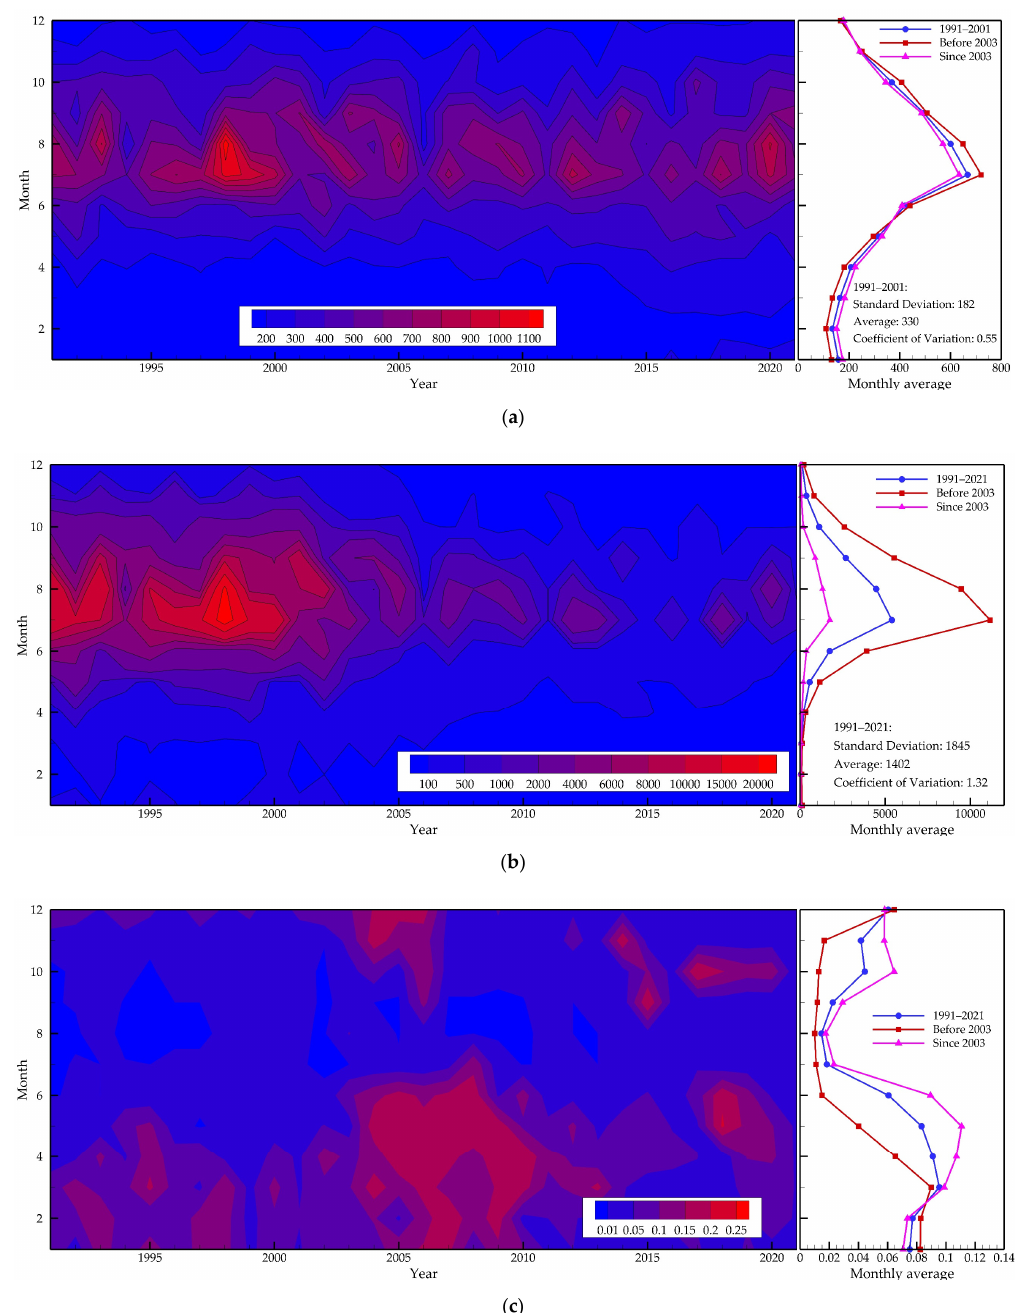
Figure 6. Contour maps of the monthly distribution and multiyear average values at Shashi station. ( a ) Runoff, unit: 10 8 m 3 ; ( b ) Sediment discharge, unit: 10 4 t; ( c ) Median particle diameter, unit: mm.